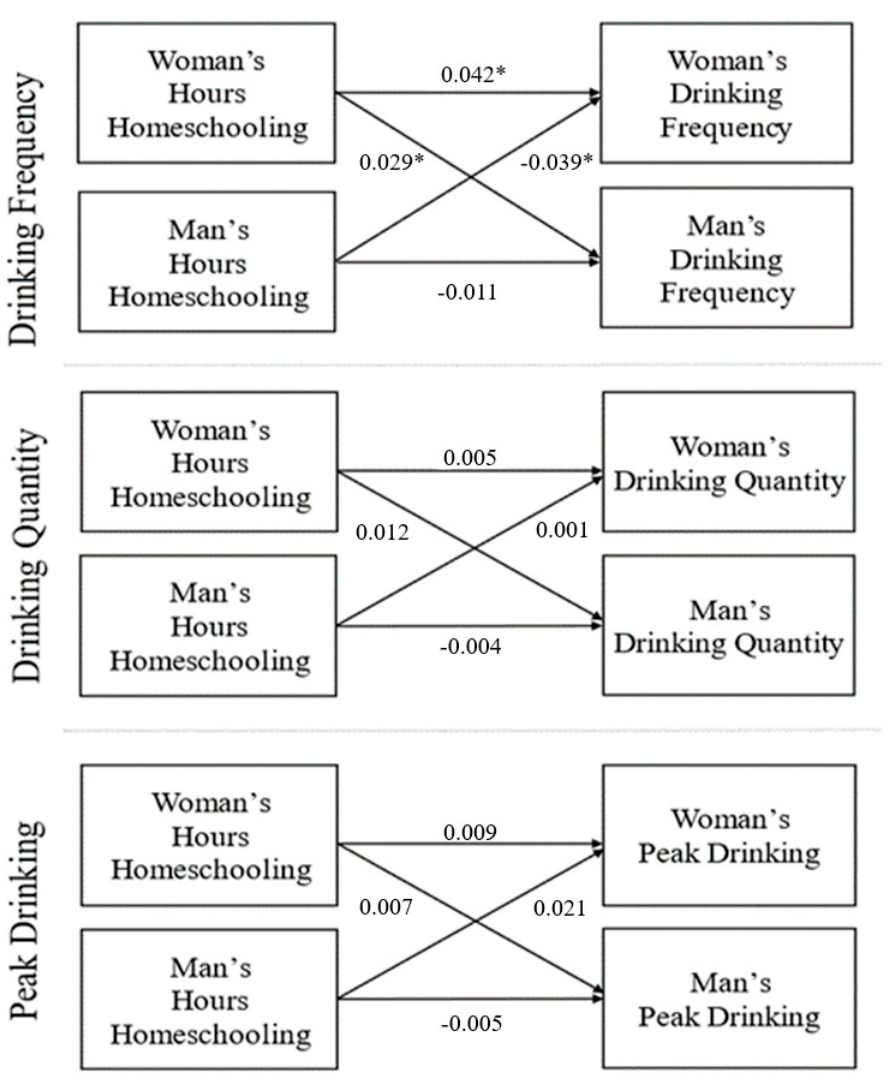
Figure 3. Actor–Partner Interdependence Models (APIM; Distinguishable Dyads) examining hours spent homeschooling on drinking outcomes for men and women. * p < 0.05; ** p < 0.01; *** p < 0.001.